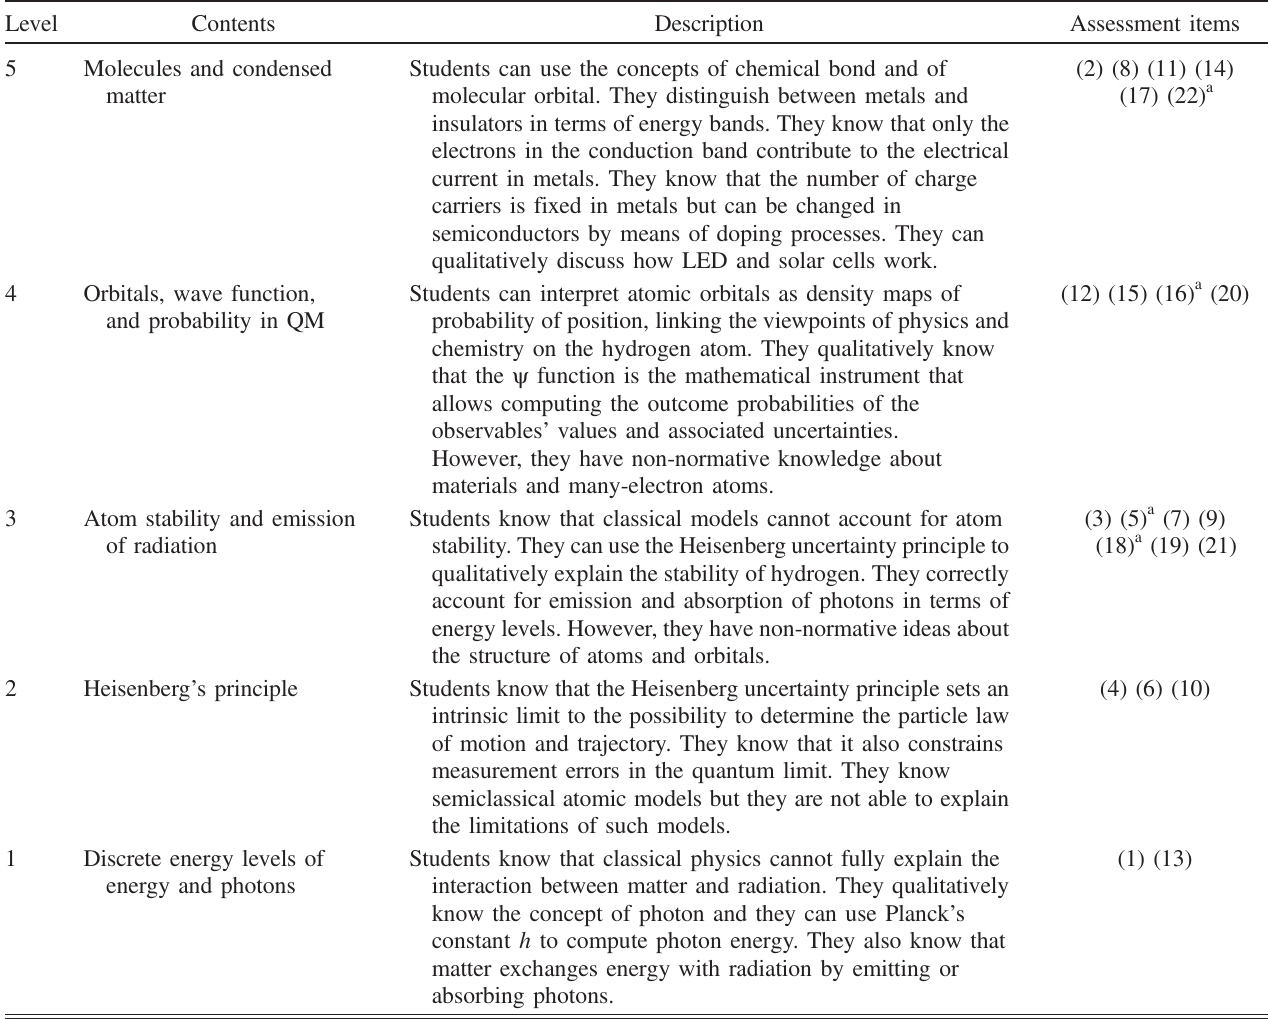
TABLE I. Overview of the hypothesized construct map used to describe students ’ progression when learning introductory topics in QM. Levels are numbered from the simplest (1) to the most advanced